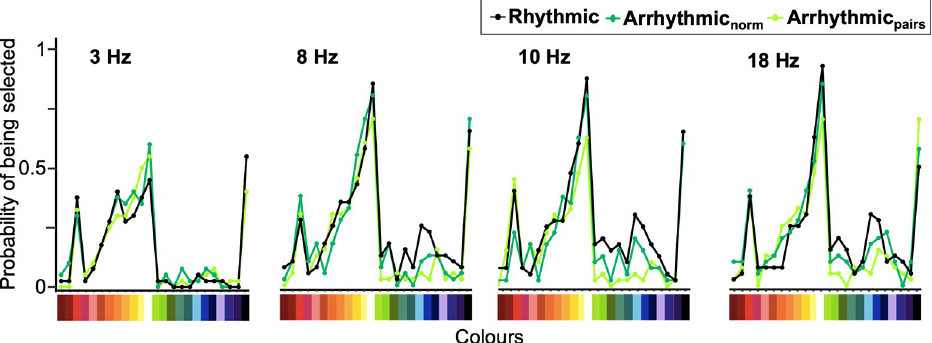
Fig 3. Effects of rhythmicity and frequency on colour selection, depicted as a probability of each colour being selected. This is expressed as sum of selections over the n = 20 participants. The mean selection probability is displayed, where for each participant the probability was based on the average of the first and second session (0, 0.5 or